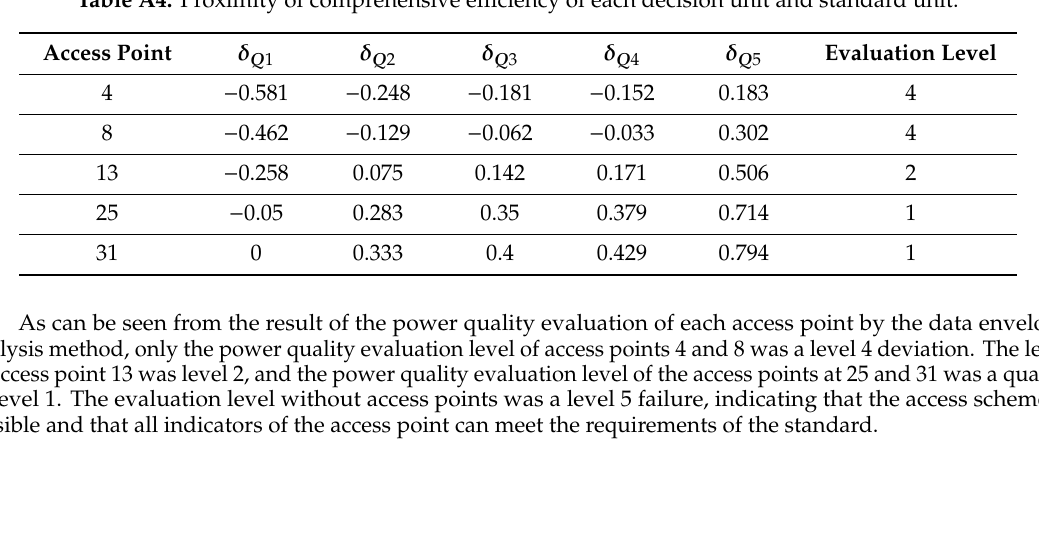
Table A4. Proximity of comprehensive e ffi ciency of each decision unit and standard